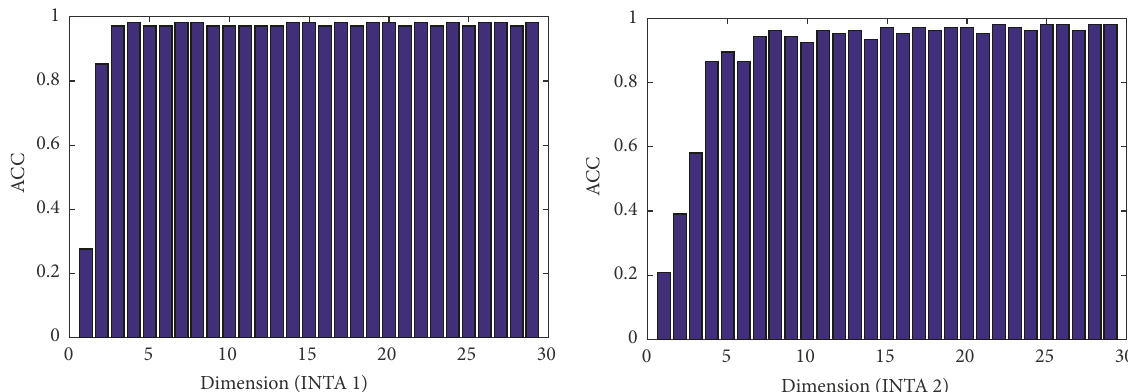
Figure 2: Influence of dimension on classification